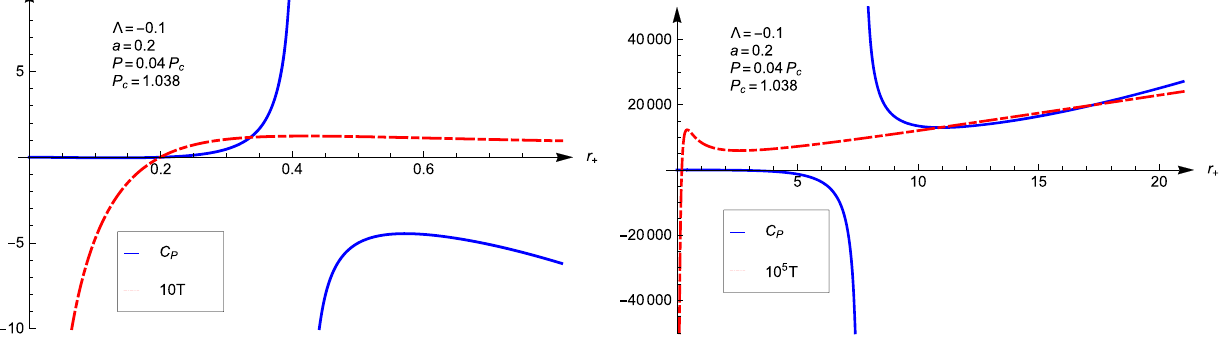
Fig. 7 Heat capacity versus r + for (cid:2) = − 0 . 1, a = 0 . 2 and P = 0 . 04 P c , which shows divergencies in two different regions. The dashed line corresponds to 10 T (right panel) and 10 5 T (left panel) ((cid:2) − P ) r 3 + G =